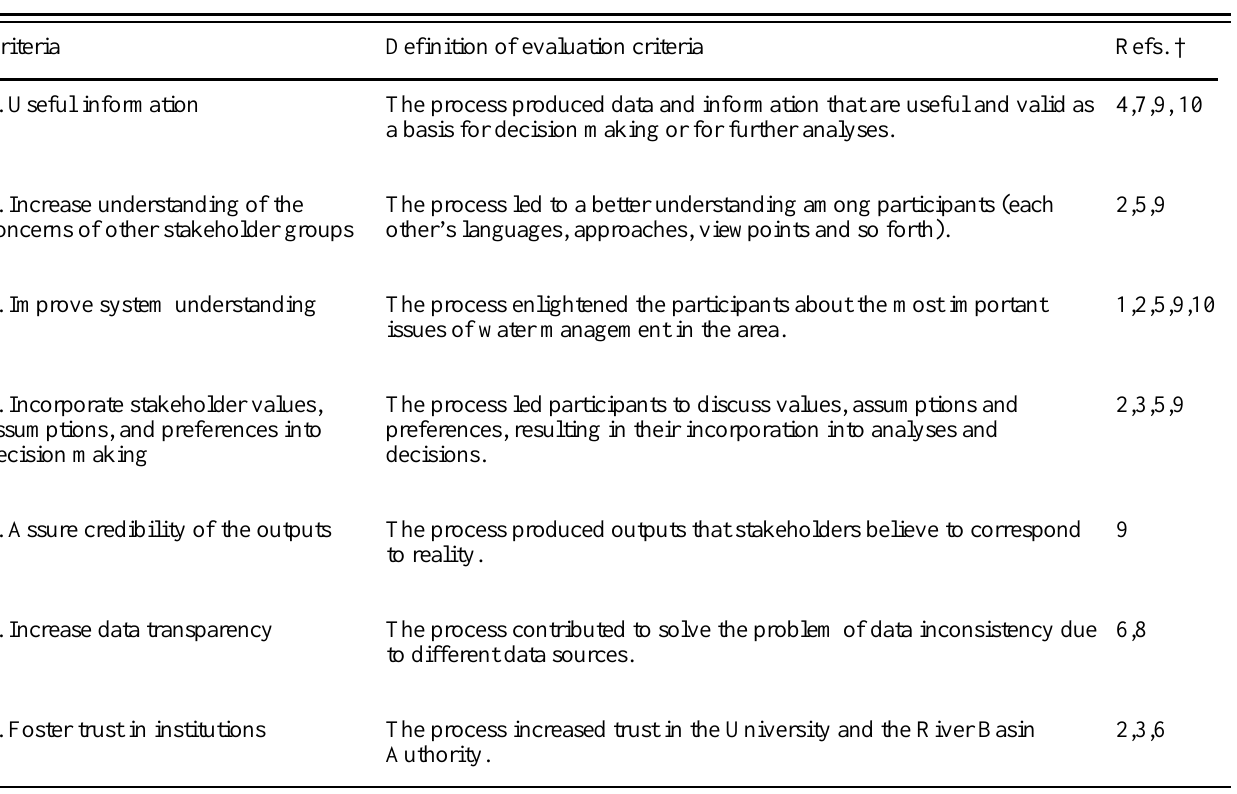
Table 3 . Criteria used to evaluate the participatory process, based on the references